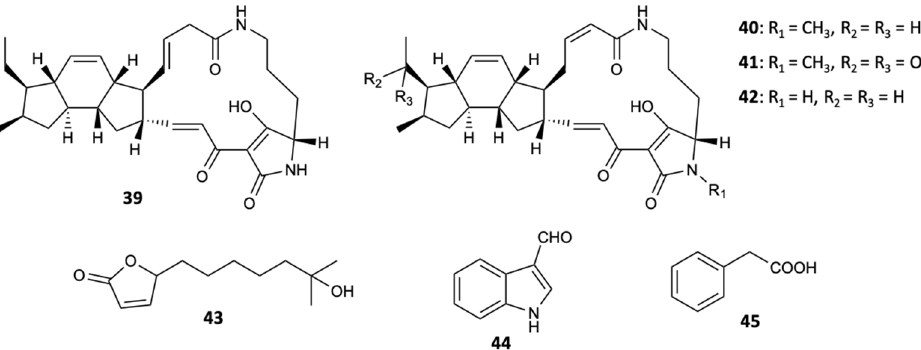
Figure 12. Structures of compounds 39 – 45 .